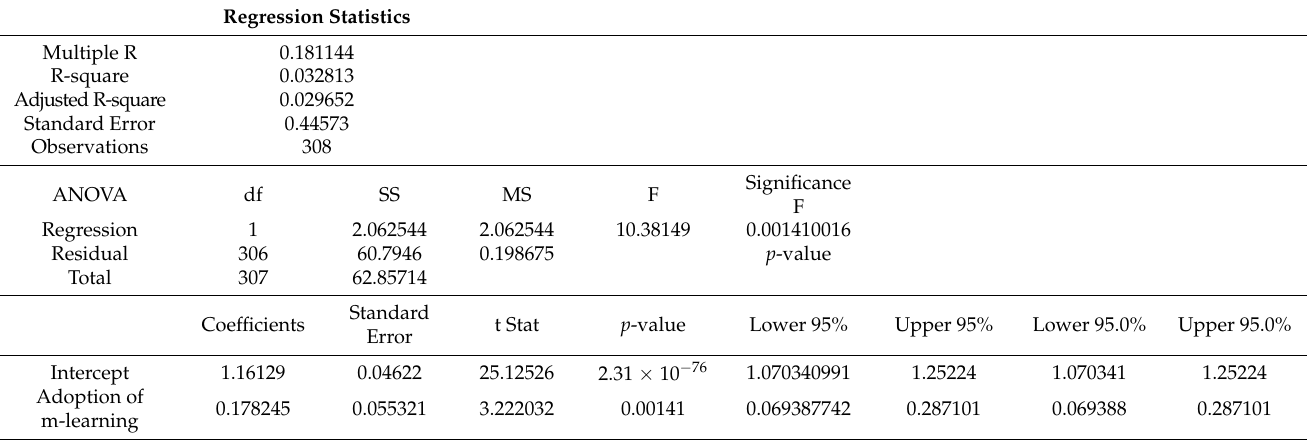
Table 8. Testing the significance of the relationship between private/public university enrollment and the adoption of